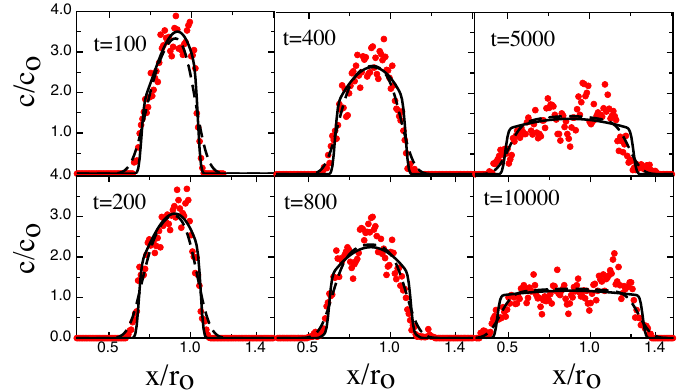
Figure 8. The red circles are results of coarse-graining BD-simulations for the retraction profile. The bold black curve is the NPDE model output with the degree of extensional fluctuations determined from the initial profile ( σ = 0.013 r o ); the dashed bold curve is the NPDE model output with the degree of extensional fluctuations determined by fits to the equilibrium profile ( σ = 0.06 r o ). The degree of thermal broadening clearly increases at longer times as the profile approaches